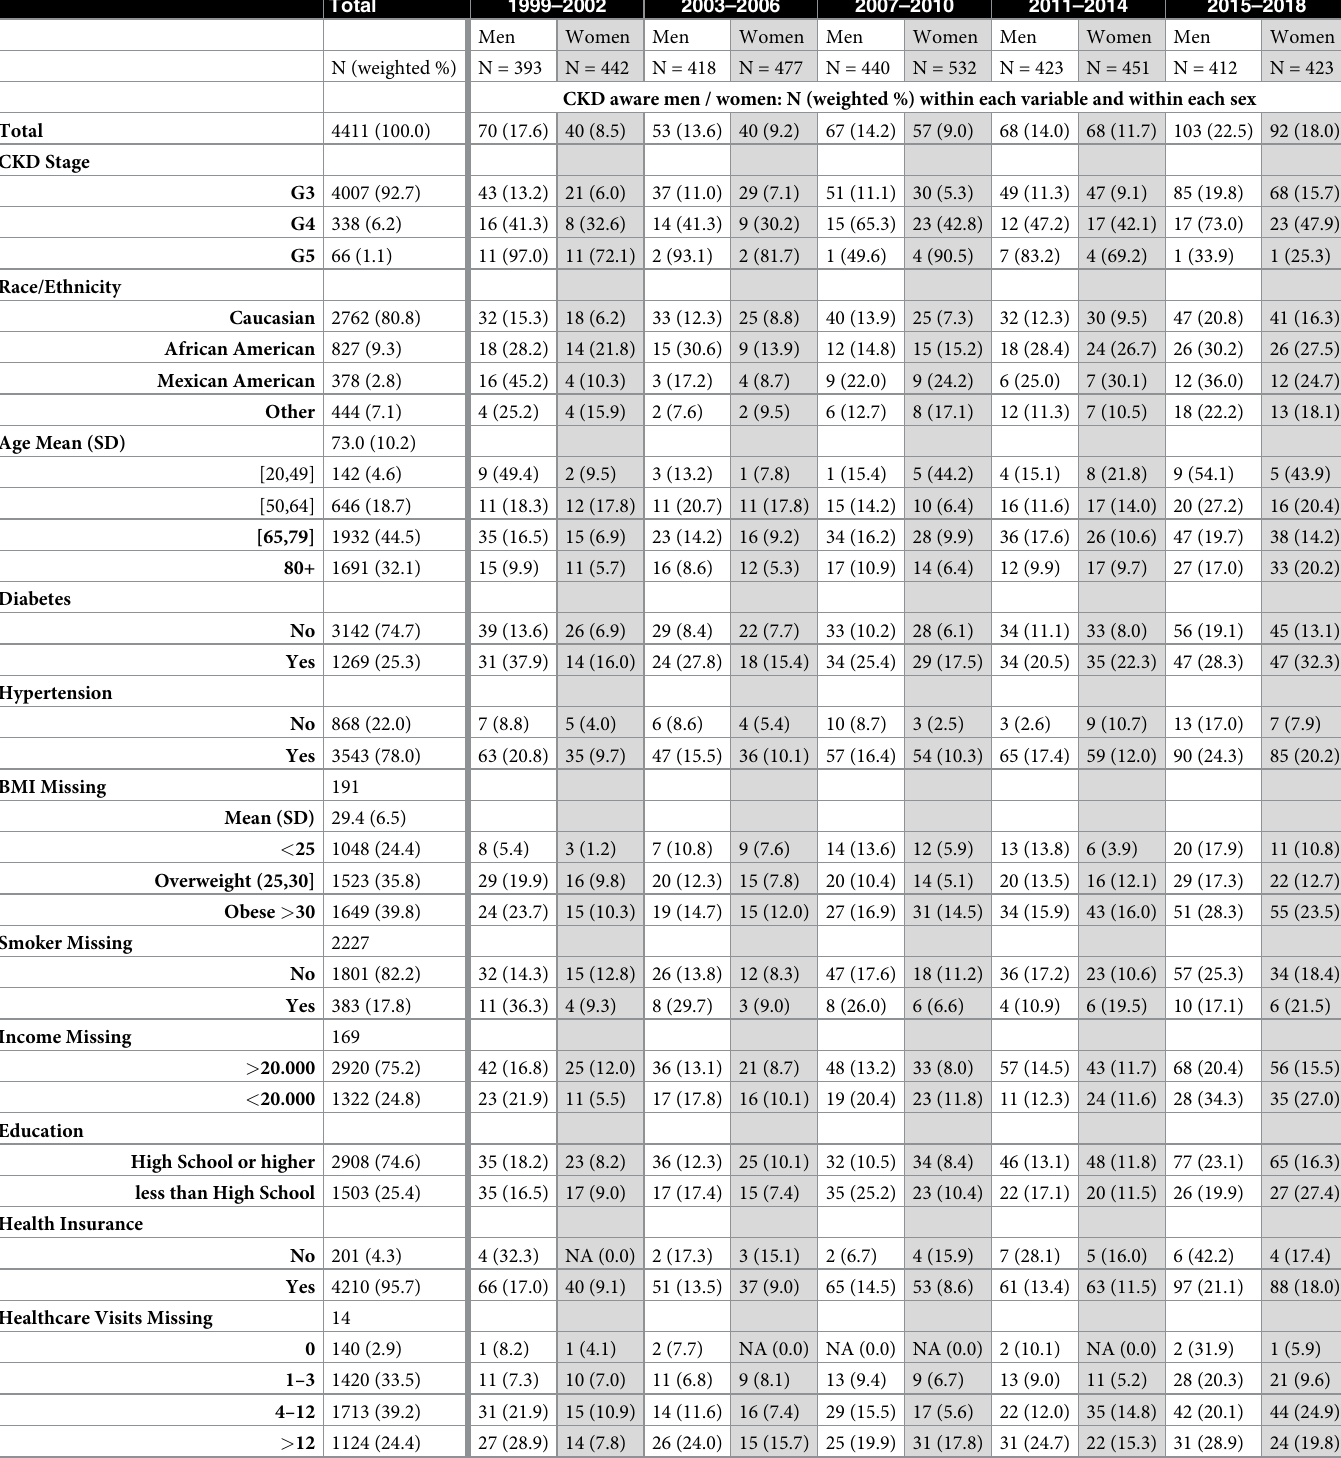
Table 1. Characteristics of NHANES participants with CKD in stages G3 –G5 (study sample) and of those individuals among the study sample who were CKD aware, over time and by